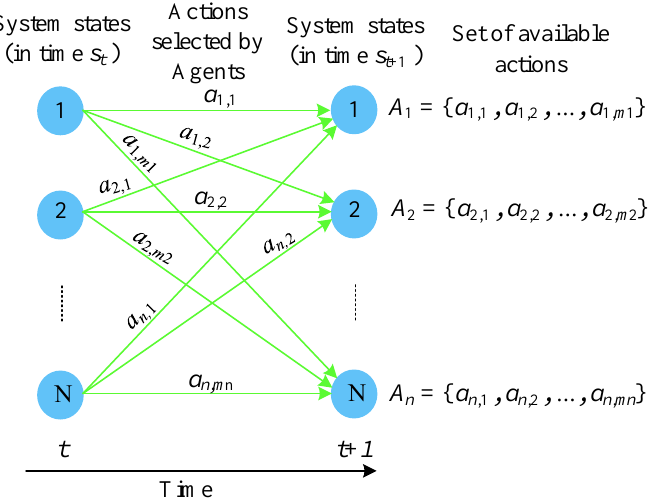
Figure 2. Stochastic Markov decision process (MDP) problem with states and the set of available